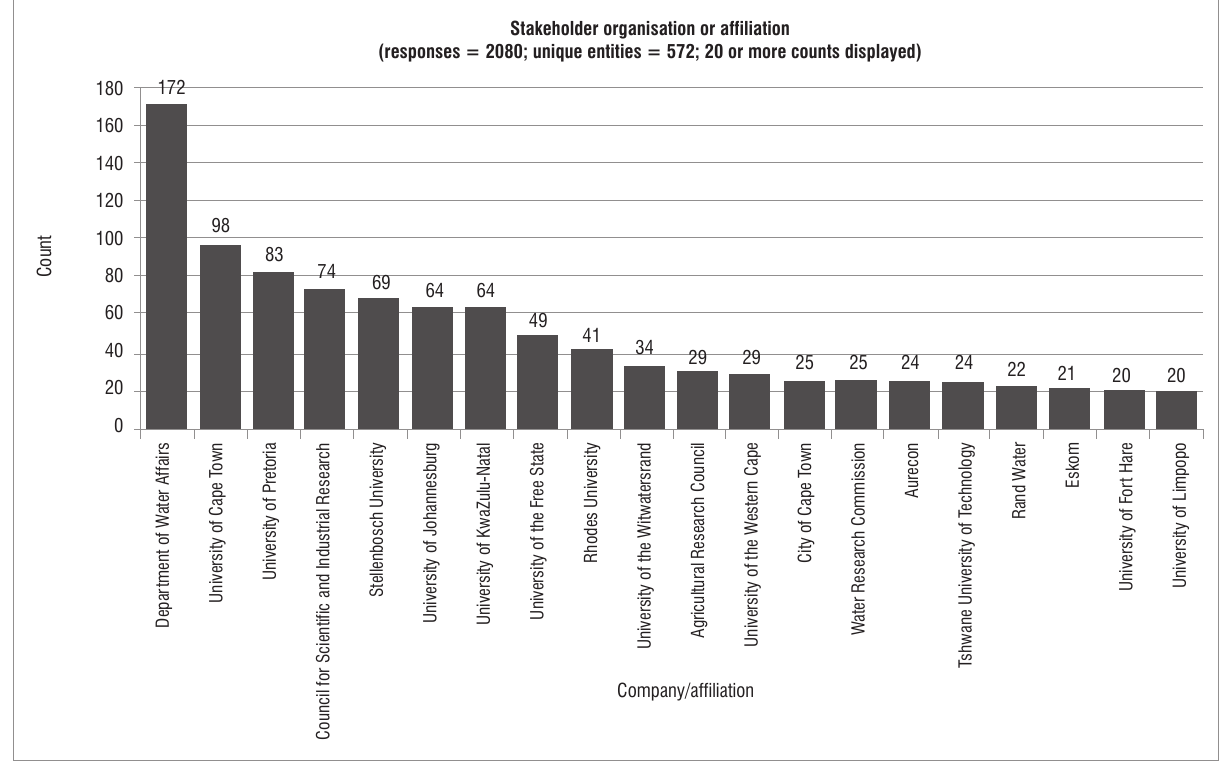
Figure 3: Distribution of stakeholder organisation or affiliation.